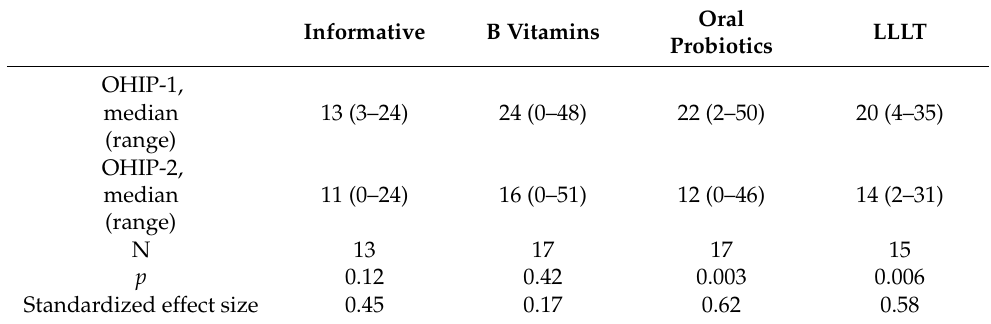
Table 6. Differences in OHIP scores before (OHIP-1) and after (OHIP-2) different types of therapy (Wilcoxon signed-rank test).